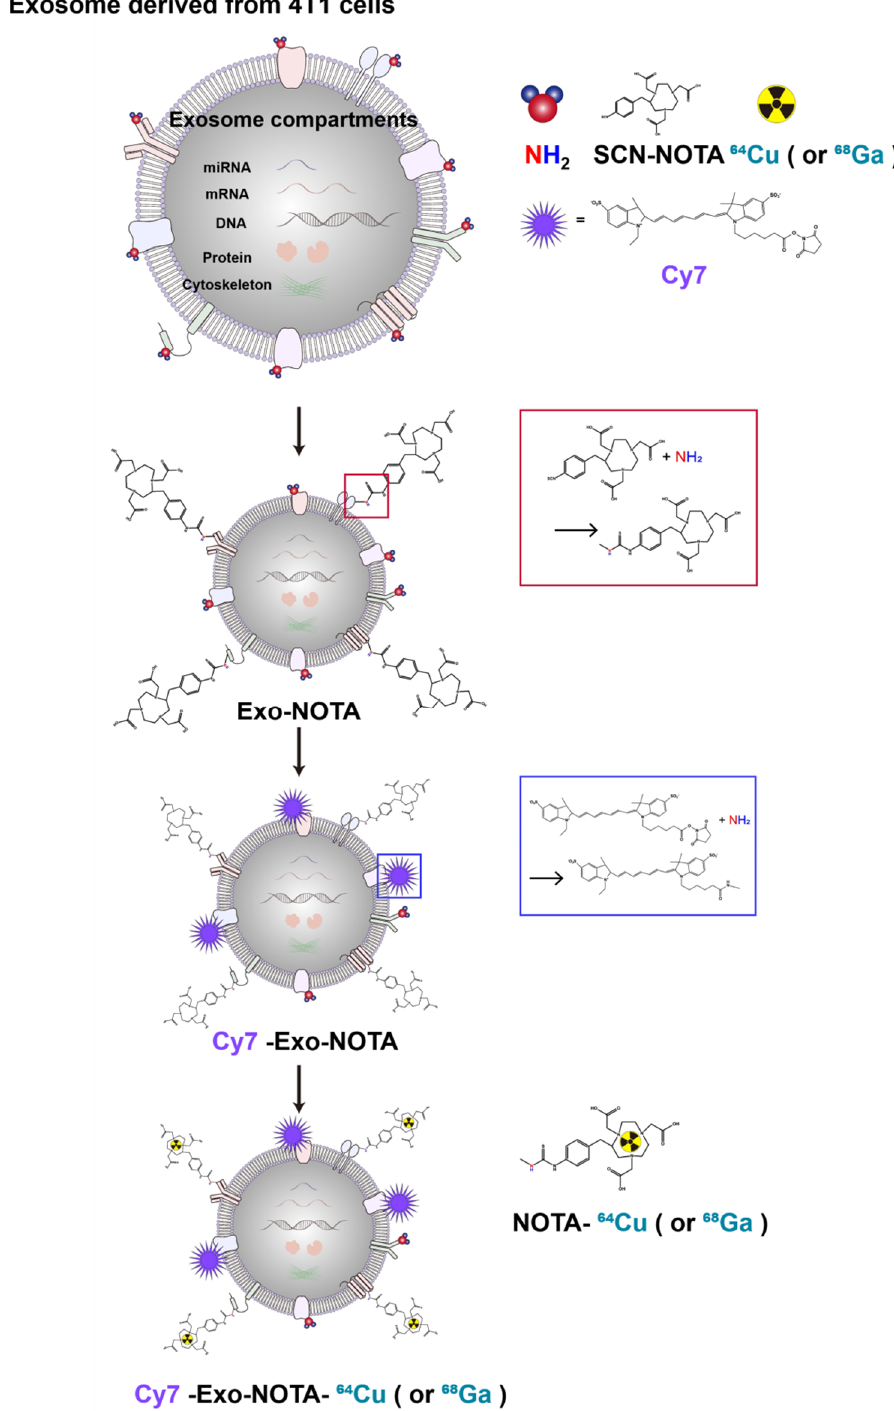
Figure 1. Experimental scheme of exosome labeling. Sequential exosome labeling steps of SCN-NOTA as a radioisotope chelator; Cy7 fluorescence dye; and 64 Cu and 68 Ga for optical and PET